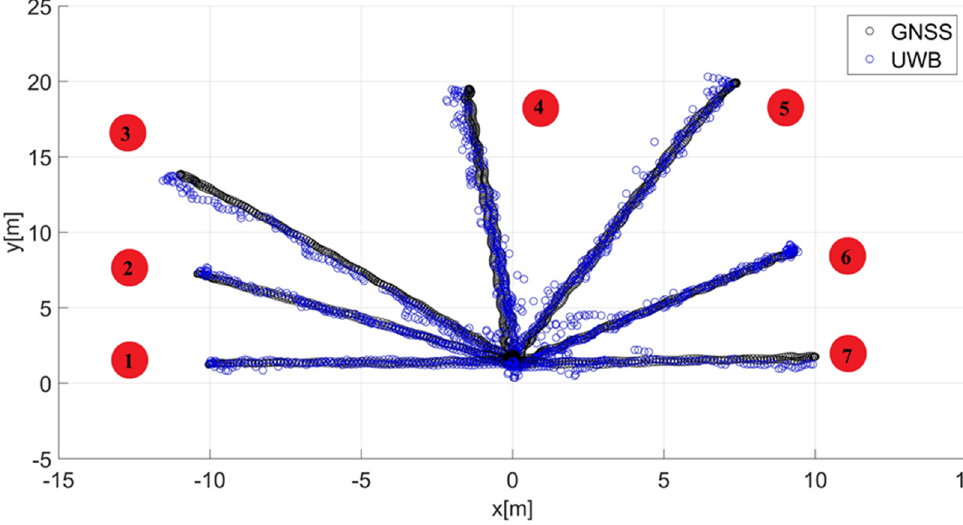
Figure 4. The results of the guide’s location for routes no. 1 − 7 using UWB technology along with the reference positions obtained using the GNSS module. Own elaboration based on [8].